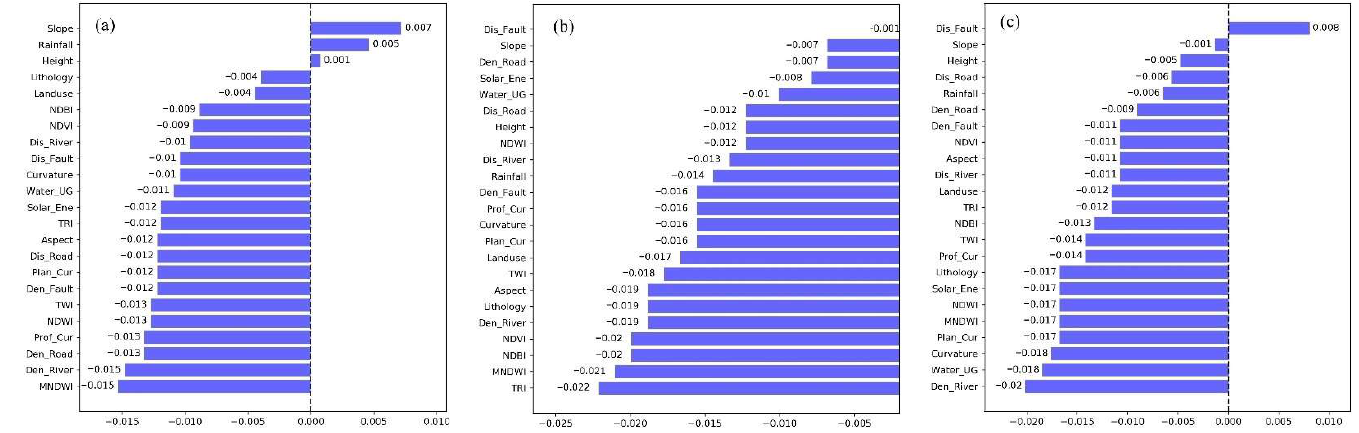
Figure 8. Feature importance ranking results using the filter-MDA feature selection method: ( a ) Landslide; ( b ) Collapse; ( c ) Unstable slope.